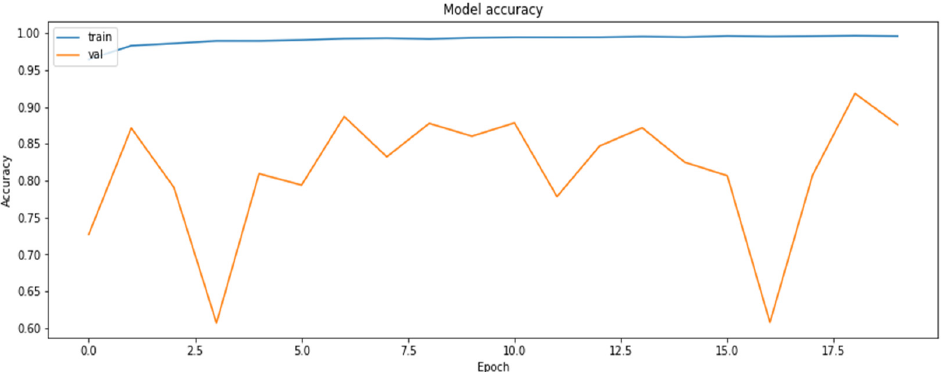
Figure 2. The accuracy of the model for the training and the validation datasets obtained based on RestNet18 model.